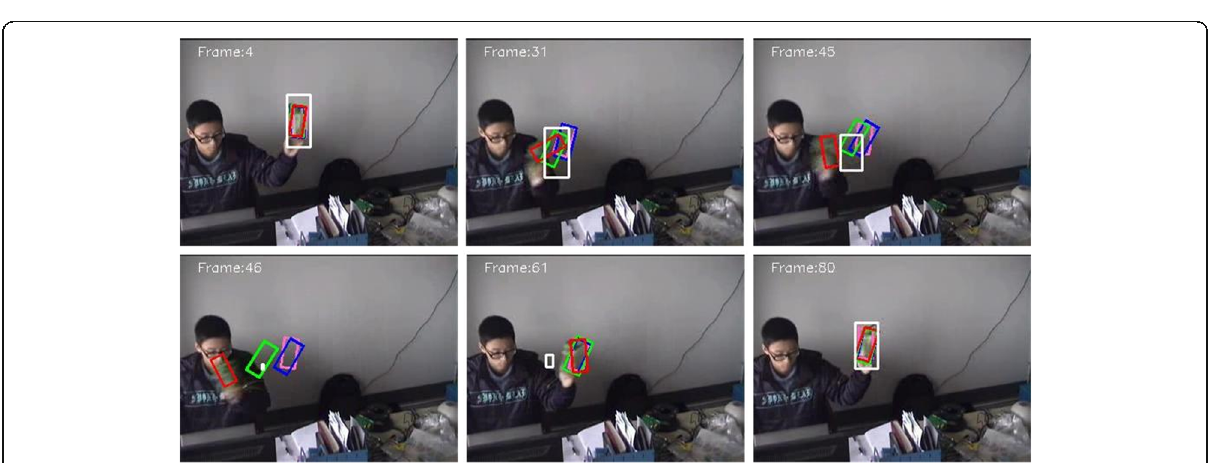
Fig. 12 The tracking results for the video “ bottle ” using CAM-Shift (white), PF (blue), VAPF (green), M-PF (pink), and the proposed tracker (red). Particle number N = 200